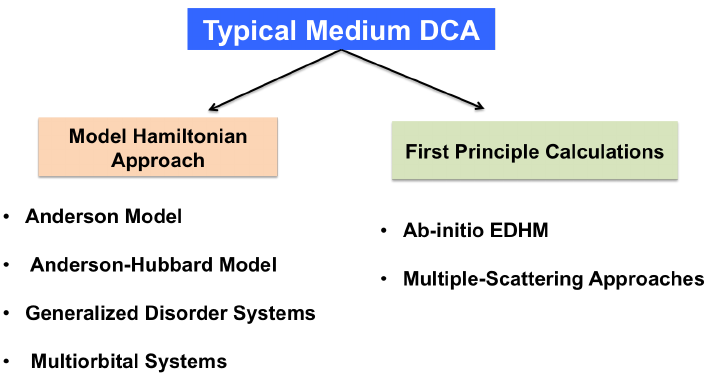
Figure 3. The TMDCA may be used to study electron localization in both simple model Hamiltonians as well as those extracted from first-principles